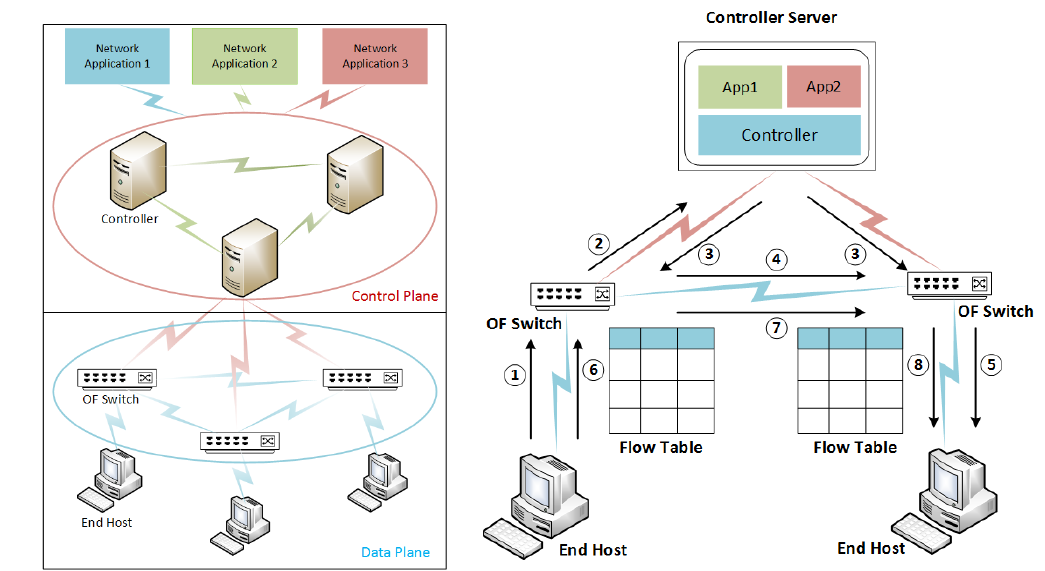
Figure 1. An SDN architecture and basic traffic flow in SDN